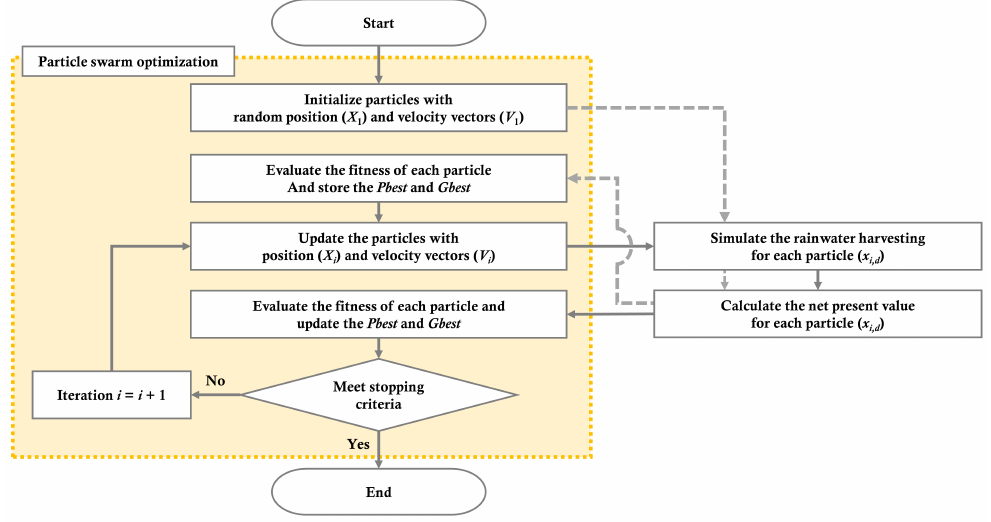
Figure 5. A schematic diagram of the connection between a rainwater harvesting system simulation model and a particle swarm